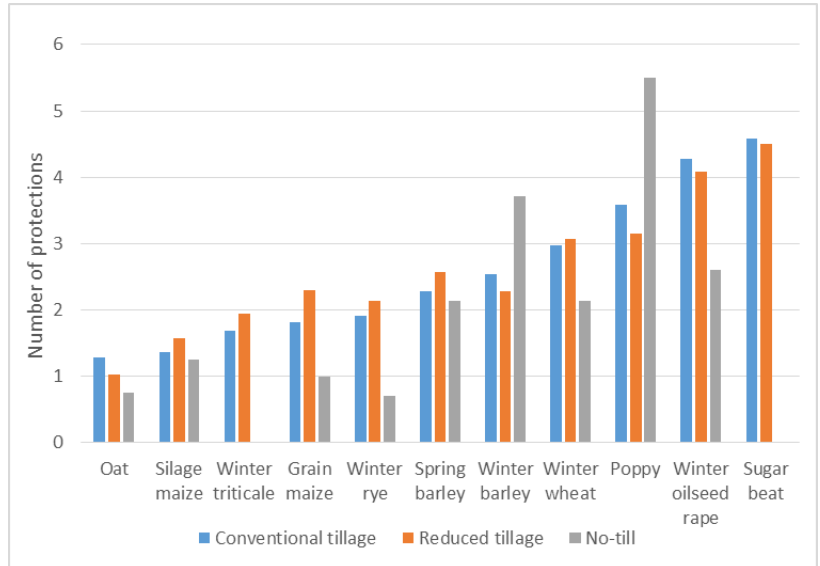
Figure 5. The number of chemical protections of evaluated crops.